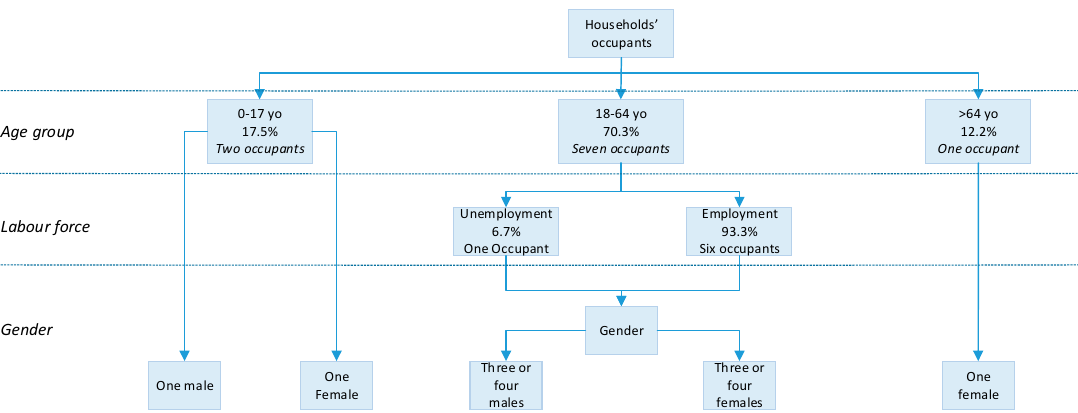
Figure 3. The application of the Wepro model’s structure to the case-study city, namely Amsterdam, The Netherlands. It consists of the Amsterdam age group share, labour force composition share and gender share of each age group and their capacity of the occupants to be modelled.